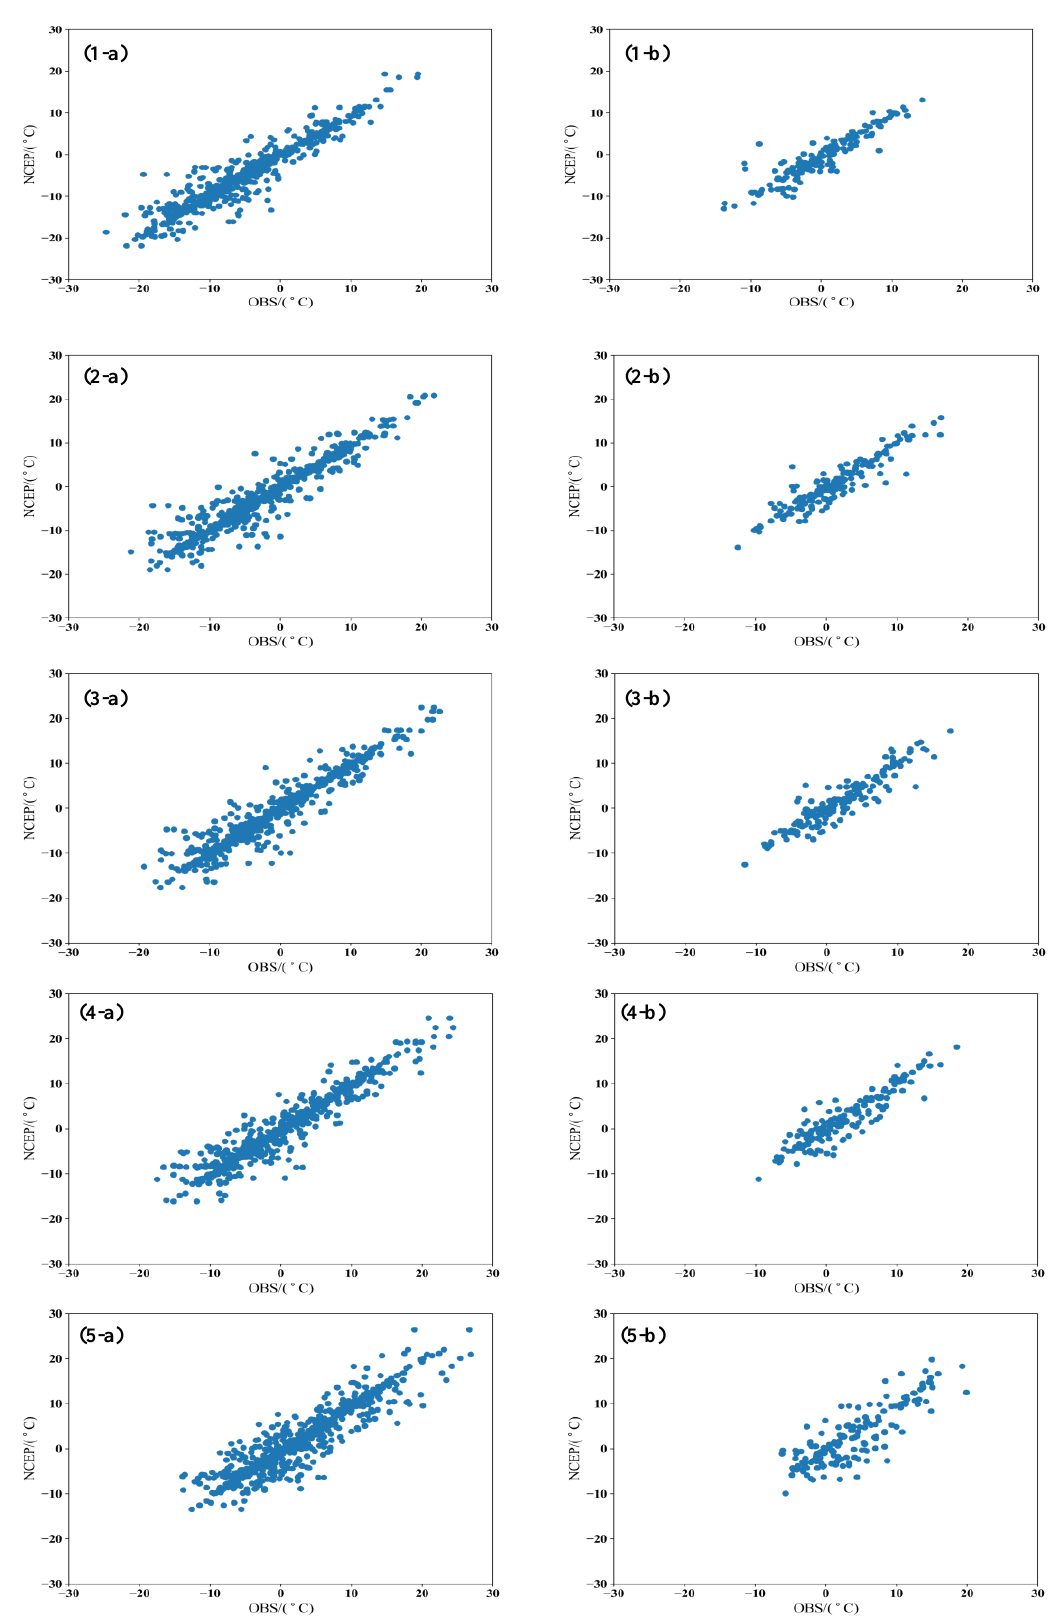
Figure 4. Correlation of the temperature between the observations and NCEP/FNL reanalysis data at ( 1 ) 850, ( 2 ) 900, ( 3 ) 925, ( 4 ) 950, and ( 5 ) 1000 hPa during the ( a ) clean days and ( b ) polluted days.